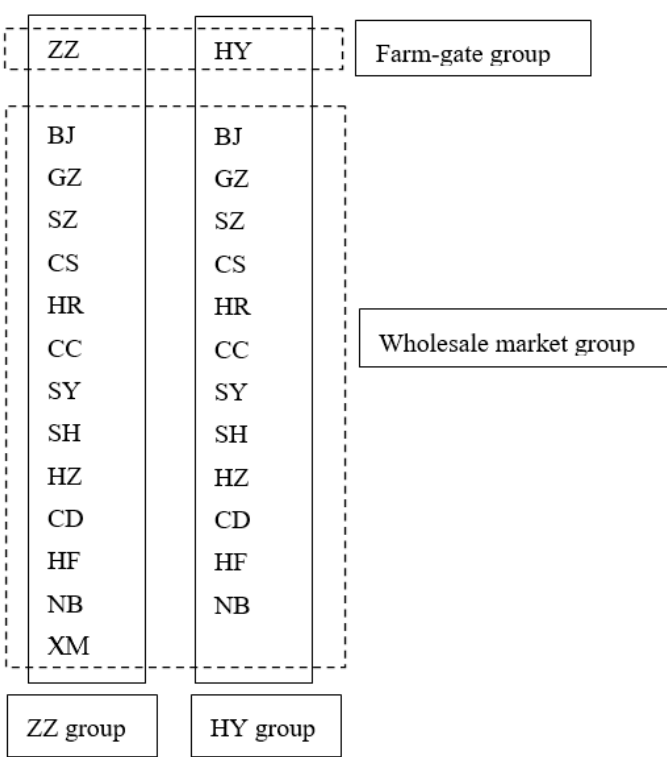
Table 2. Source and market description in wholesale price.